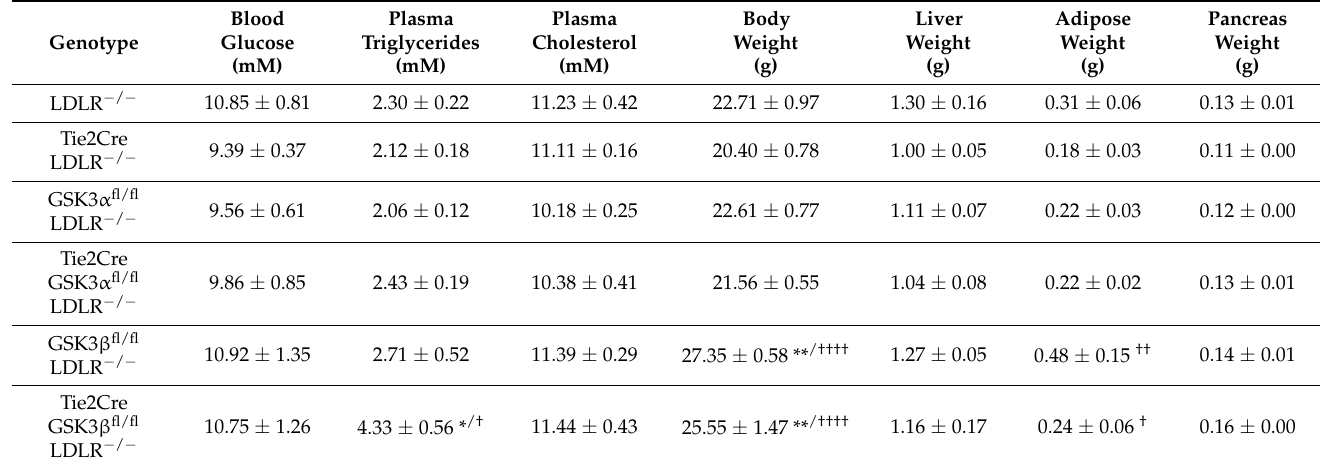
Table 1. Metabolic Parameters for endothelial/macrophage knockout